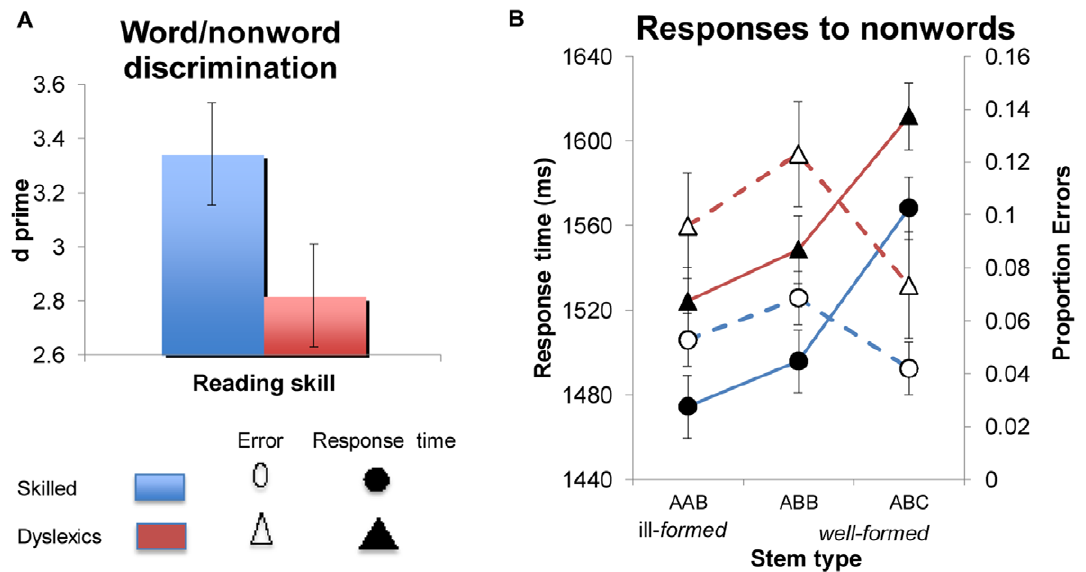
Figure 1. Word/nonword discrimination. ( A) Discrimination (d 9 ) by dyslexics and skilled readers (controls). (B) The sensitivity of dyslexics and controls to the phonological structure of Hebrew stems in the discrimination of auditory nonwords from words (Error bars are confidence intervals for the difference between the means).